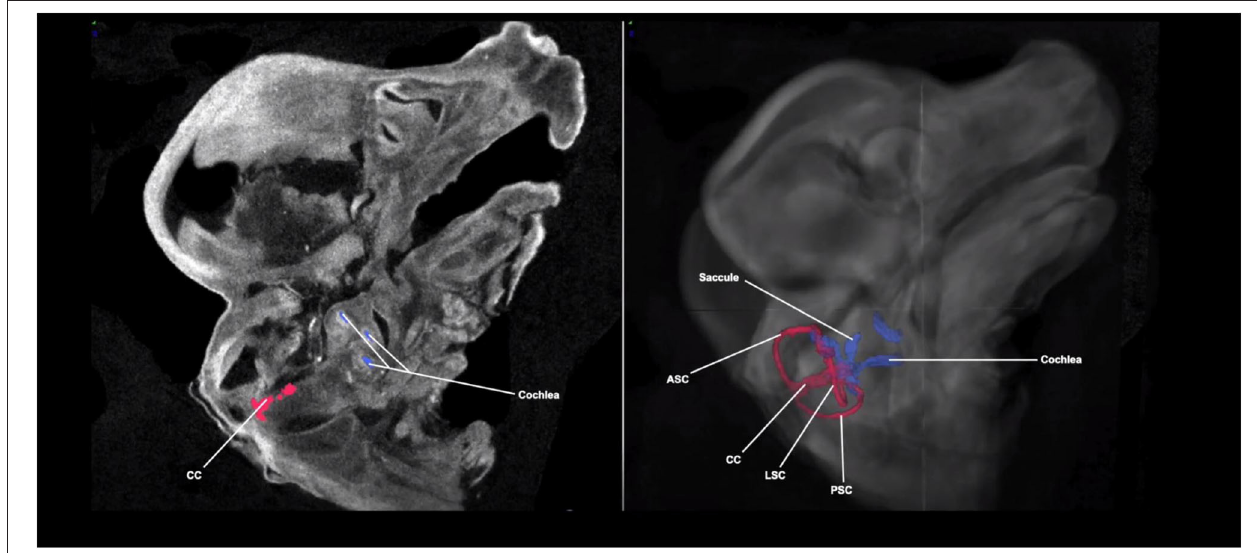
FIGURE 2 | Micro-CT image with 3D segmentation of the embryological inner ear at E14.5. The anatomy of the embryonic inner ear in the sagittal plane on the 2D Micro-CT image (left). The 3D inner ear segmentation is shown overlayed on the Micro-CT image of the embryo head (right). The rudimentary semi-circular canals and common crus (red) and cochlea (blue) are shown. ASC, anterior semi-circular canal; LSC, lateral semi-circular canal; PSC, posterior semi-circular canal; CC, common